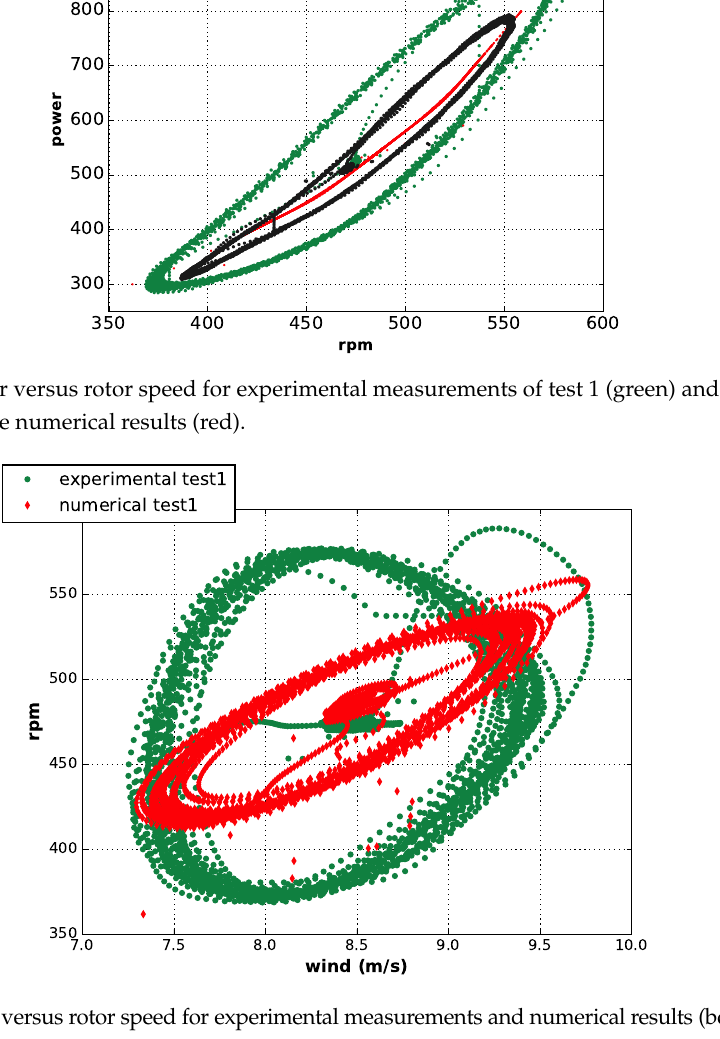
Figure 9. Wind versus rotor speed for experimental measurements and numerical results (both for test